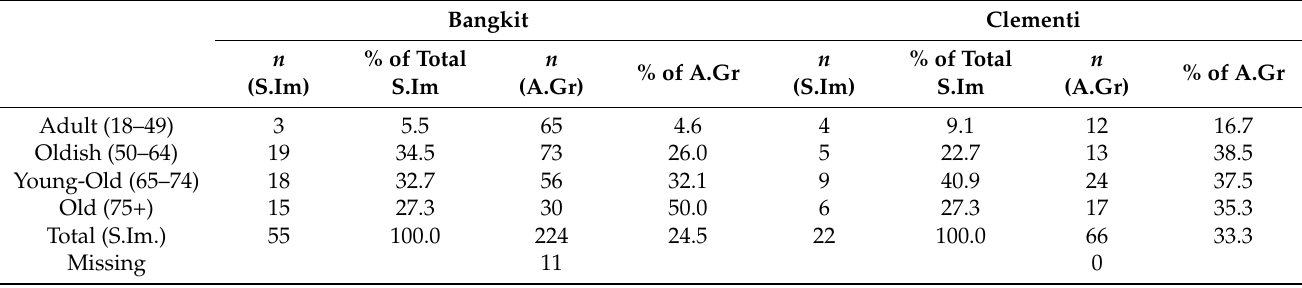
Table 3. Reported sensory impairments across age